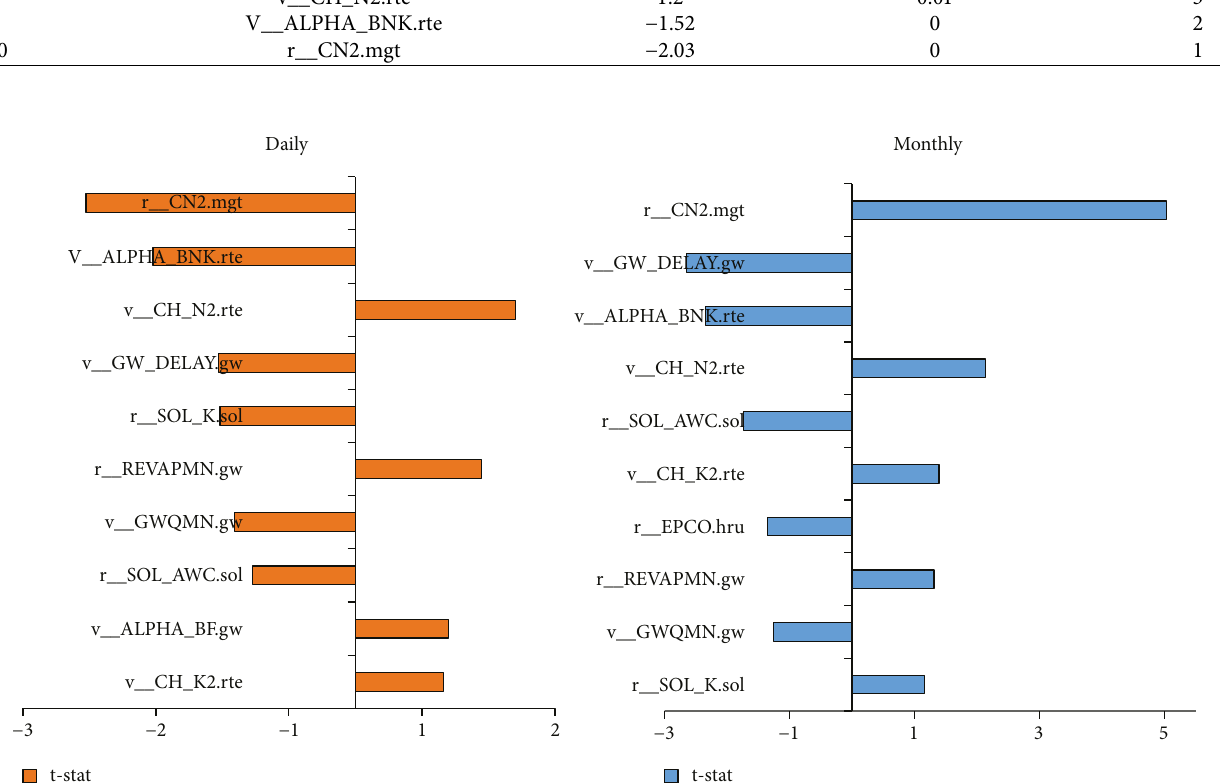
Figure 5: t -Stat of the daily and monthly most sensitive parameters using the SUFI-2 algorithm.